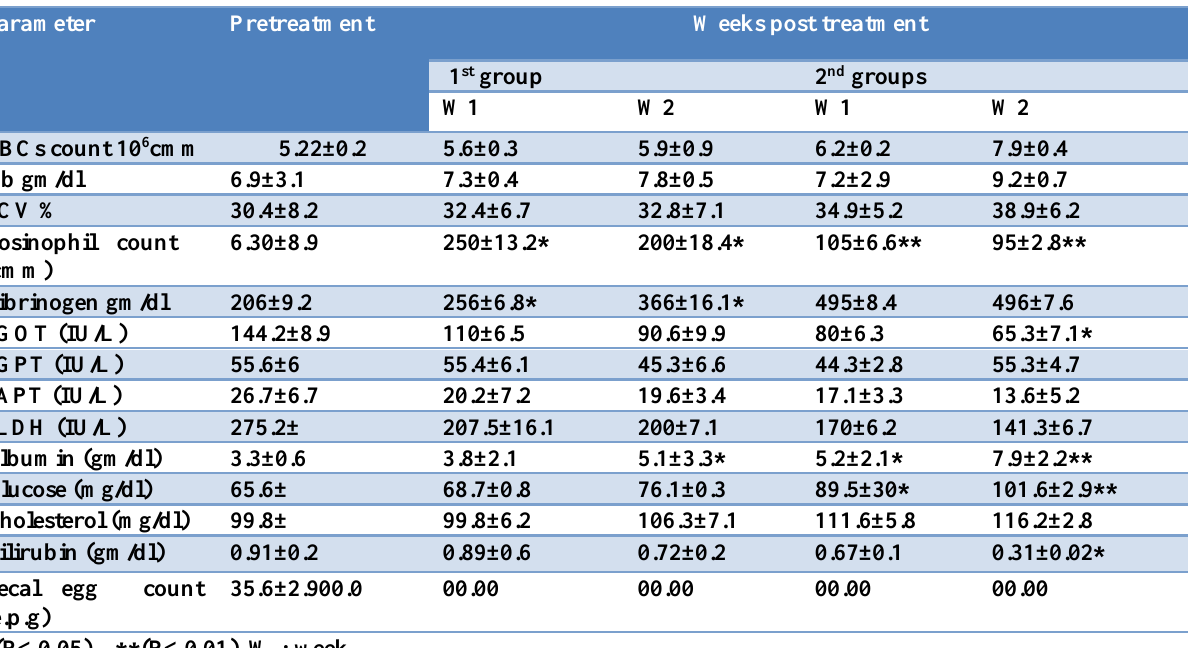
Table,2:Hematological, biochemical and fecal egg count in sheep pre and post treatment with triclabedazole and